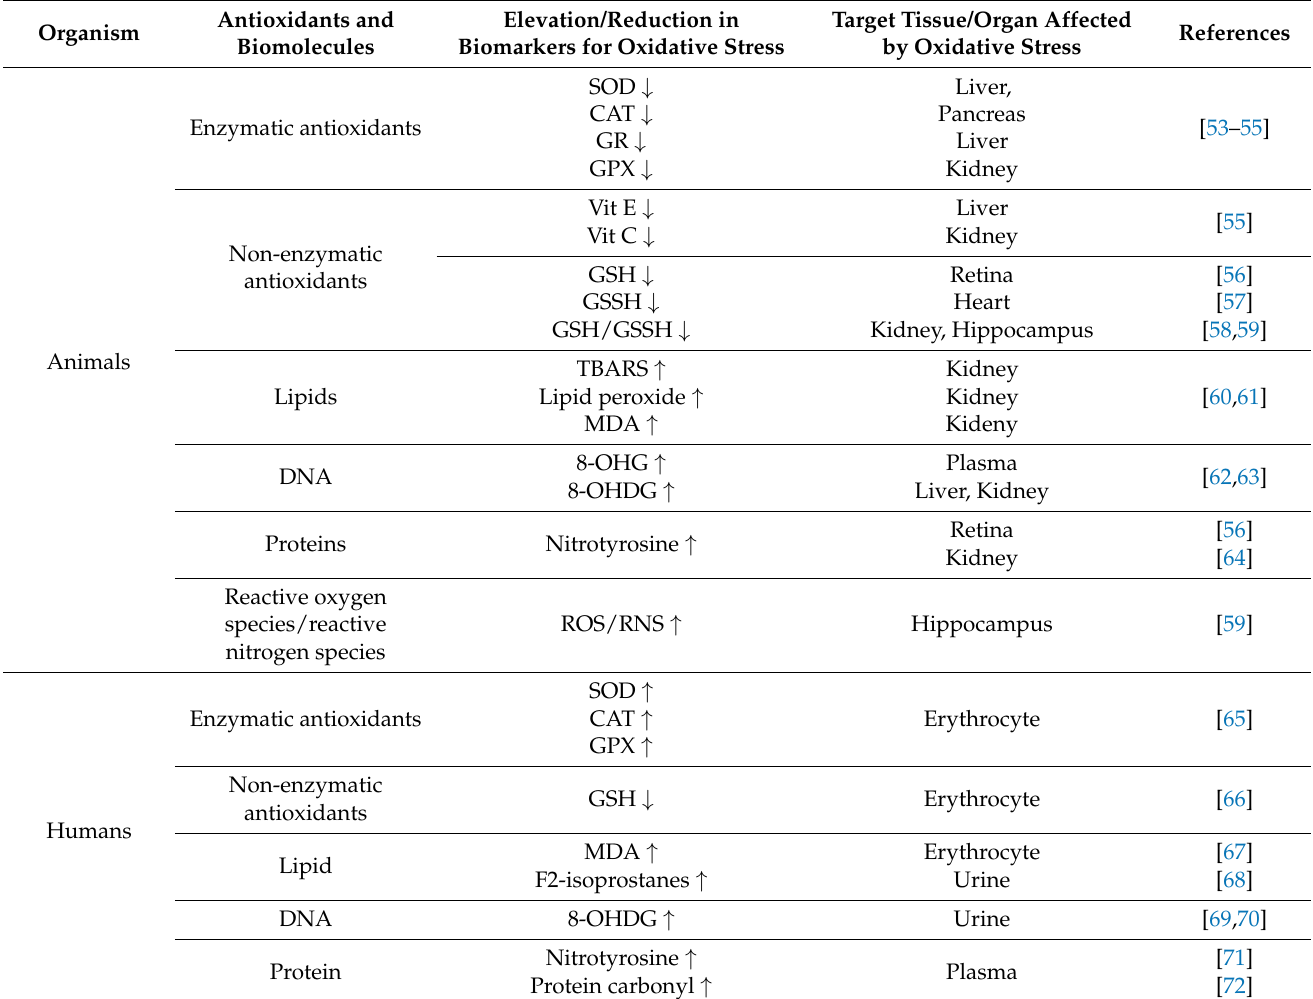
Table 1. Model subjects and experimental evidence to prove the role and effect of OS on